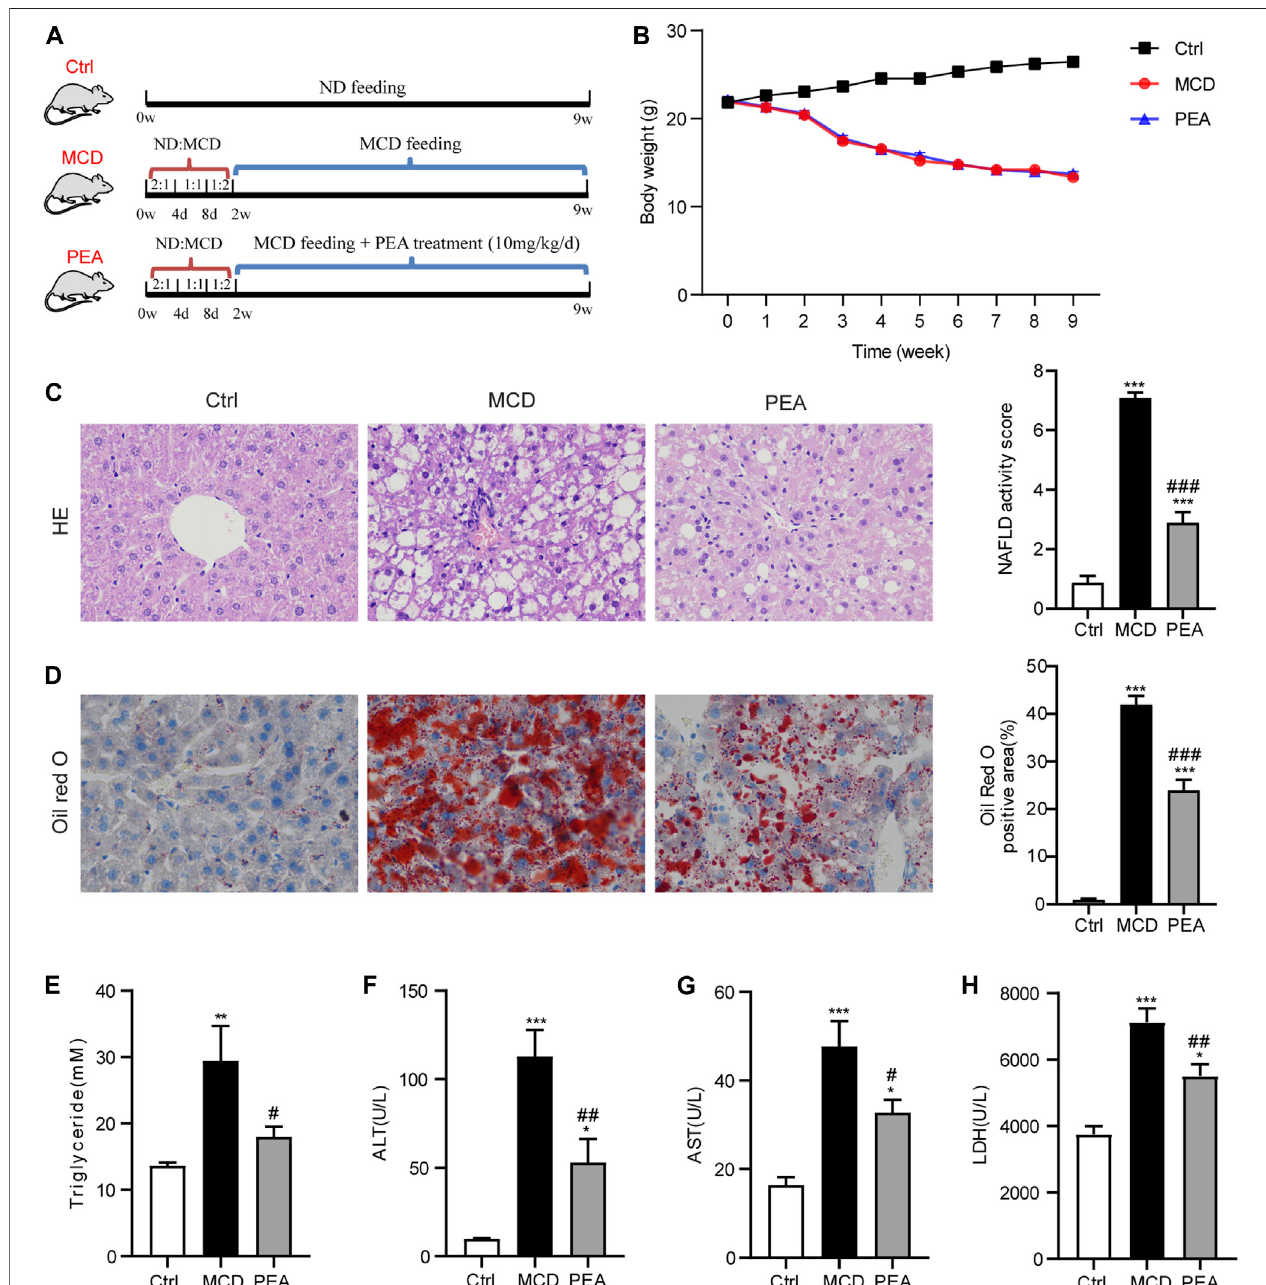
FIGURE 1 | Effect of PEA on MCD-induced steatohepatitis in mice. (A) Experiment scheme for testing the preventive effects of PEA in the MCD-treated mice. (B) Body weight during the animal experiment. (C) Liver histological changes were determined by hematoxylin-eosin (HE) staining ( × 400), and NAFLD activity score was quanti fi ed. (D) Hepatic lipid accumulation and distribution detected by Oil Red O staining ( × 400), and Oil Red O-stained area was analyzed. (E) TG levels in the liver. (F) ALT levels in plasma. (G) AST levels in plasma. (H) LDH levels in plasma. Ctrl: the mice treated with standard diet; MCD: the mice treated with MCD diet; PEA: the micetreatedwithMCD dietand PEA. Values wereexpressed asthe mean ± SEM, n (cid:1) 6 – 8foreach group. * p < 0.05, ** p < 0.01, *** p < 0.001 versusthe Ctrlgroup; # p < 0.05, ## p < 0.01, ### p < 0.001 versus the MCD group.